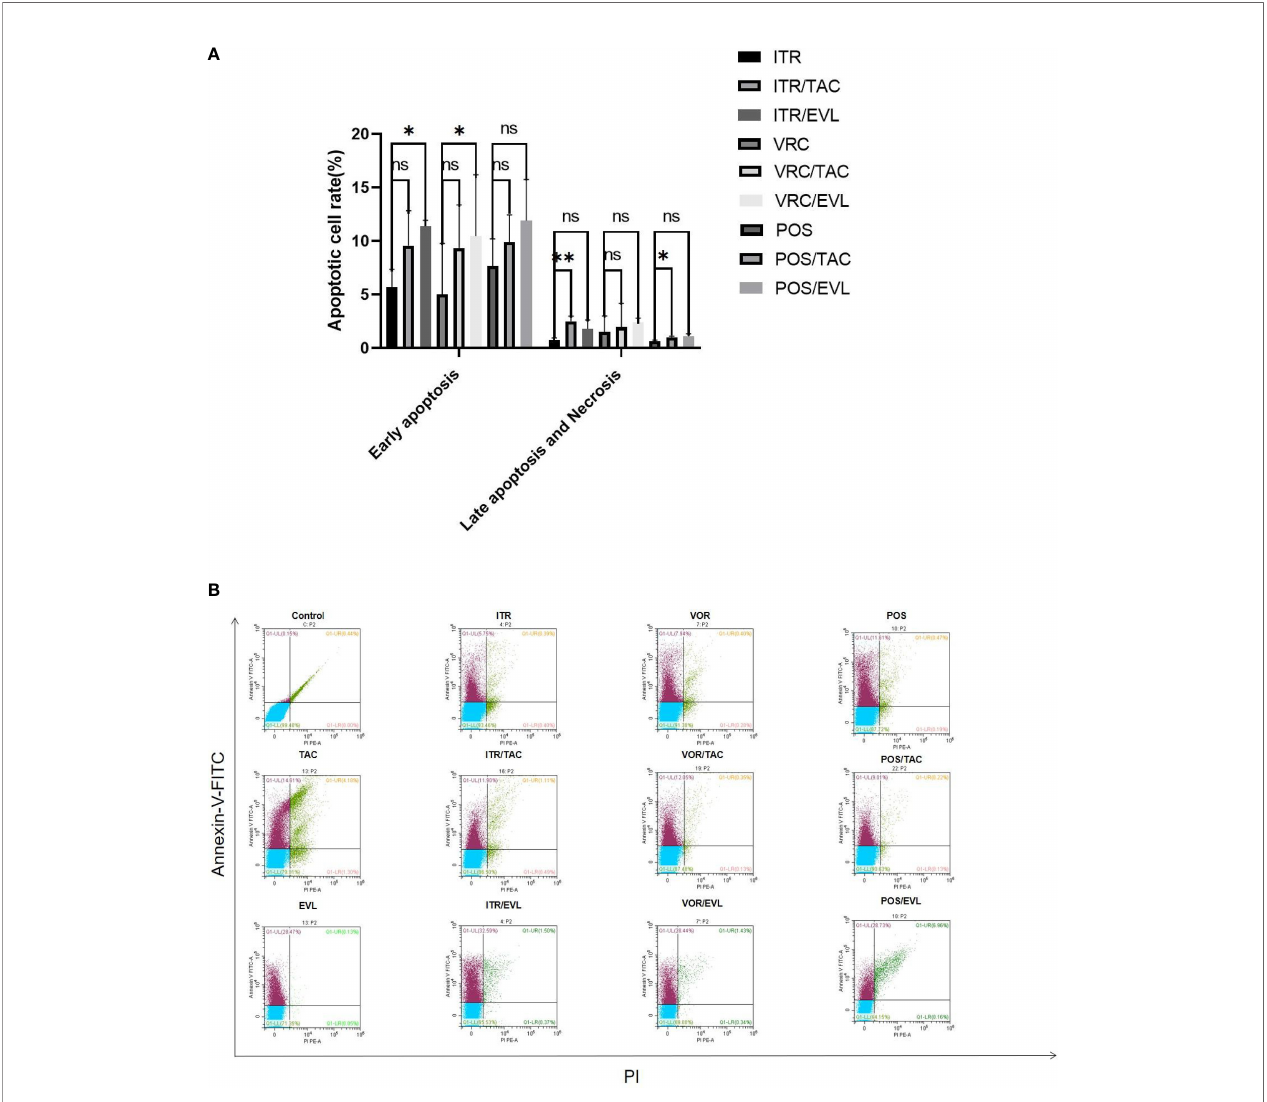
FIGURE 4 | The effect of drug treatment on apoptosis. (A) The proportion of spores undergoing apoptosis at different stages of apoptosis in the control group and the experimental group and related statistical analysis. (B) In fl ow cytometry analysis, Annexin-V-FITC and PI fl uorescents emit different wavelengths of fl uorescence in the early and late stages of apoptosis. The lower left quadrant represents living cells; the upper left quadrant represents early apoptotic cells; the upper right quadrant represents necrotic and late apoptotic cells. TAC, tacrolimus; EVL, everolimus; ITR, itraconazole; VRC, voriconazole; POS, posaconazole. *P < 0.05; **P < 0.01; ns, no signi fi